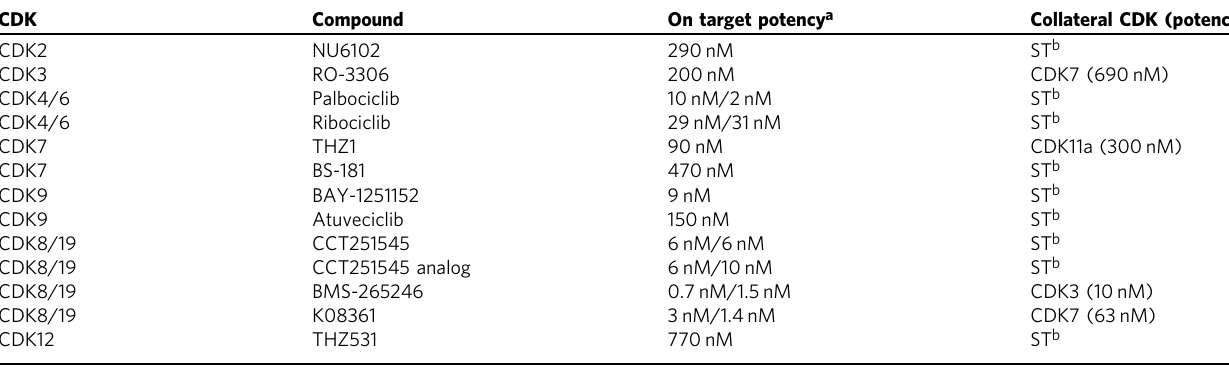
Table 1 Best CDKi ’ s identi fi ed in this study for selective target engagement in live